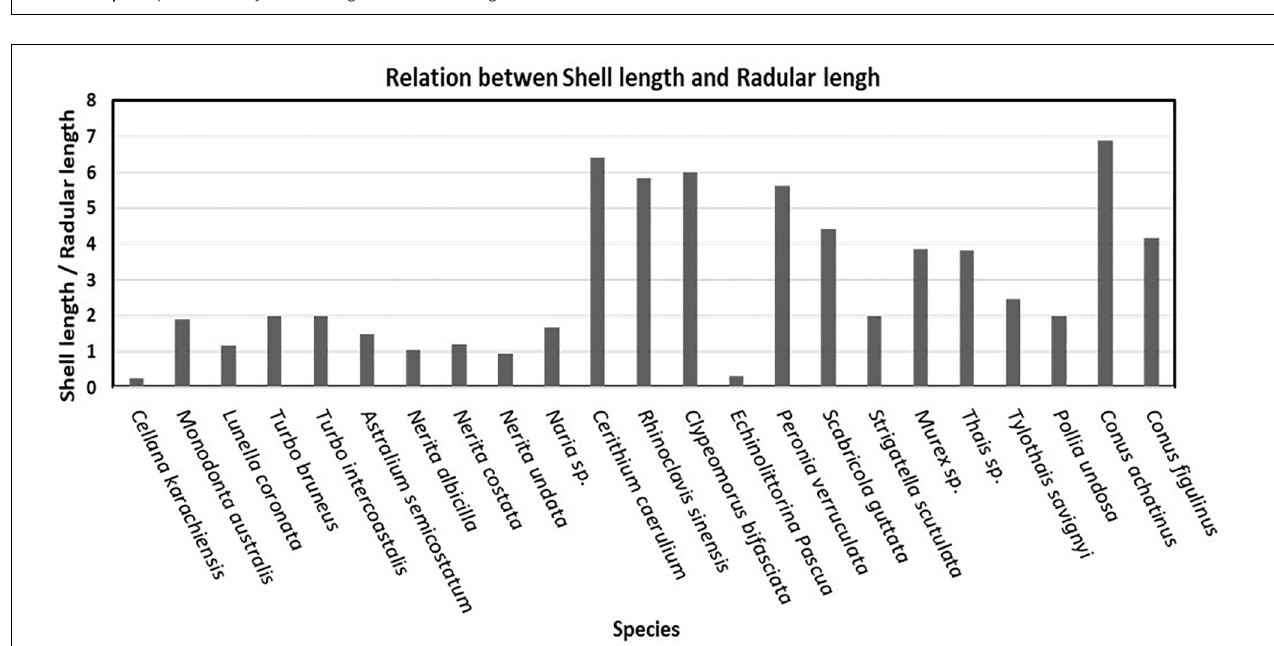
FIGURE 6 | Comparative study of shell length and radular length.